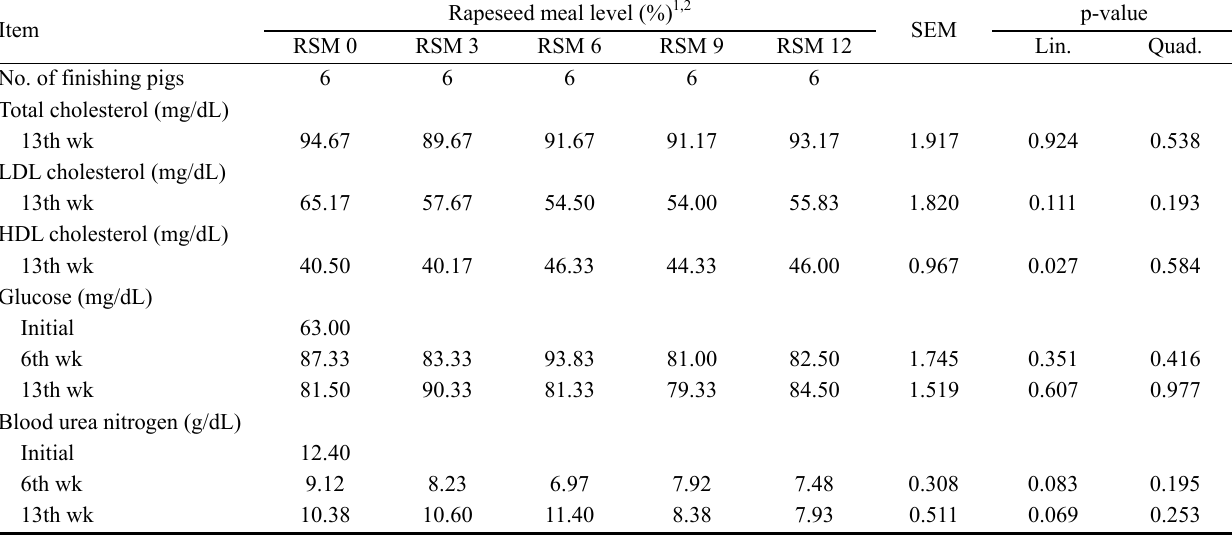
Table 8. Influence of dietary rapeseed meal (RSM) on blood profiles of growing-finishing pigs Item